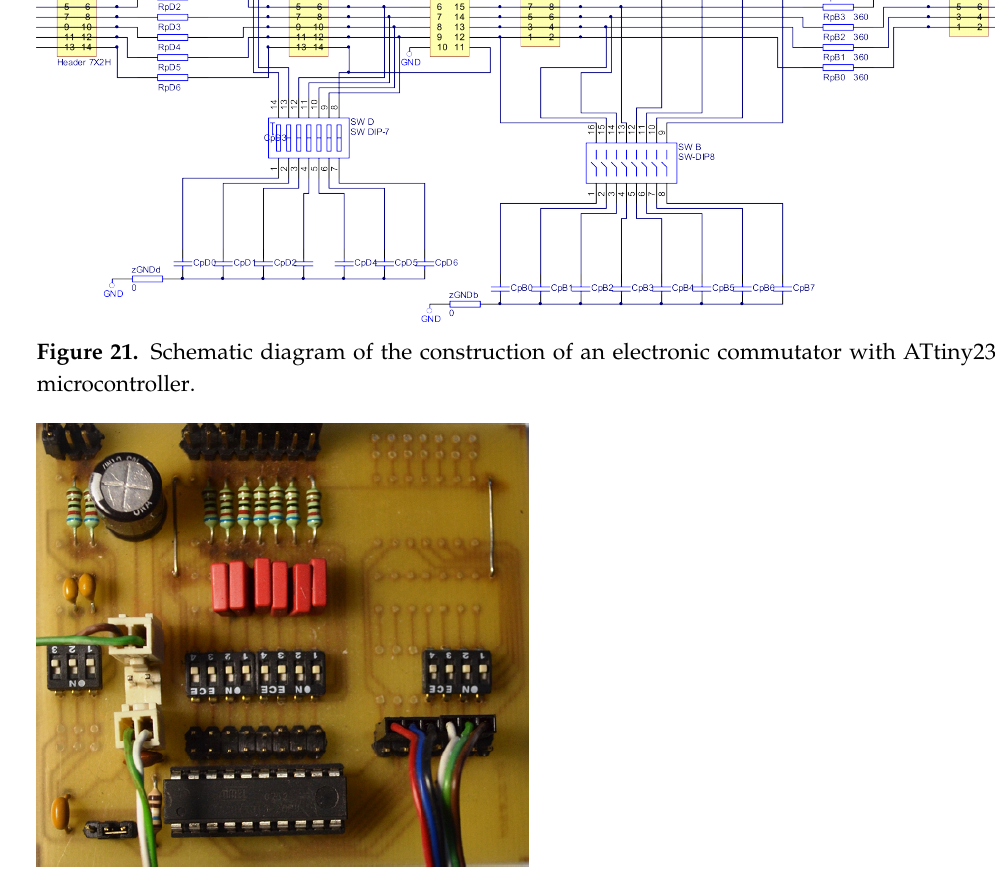
Figure 22. Electronic commutator circuit with ATtiny2313